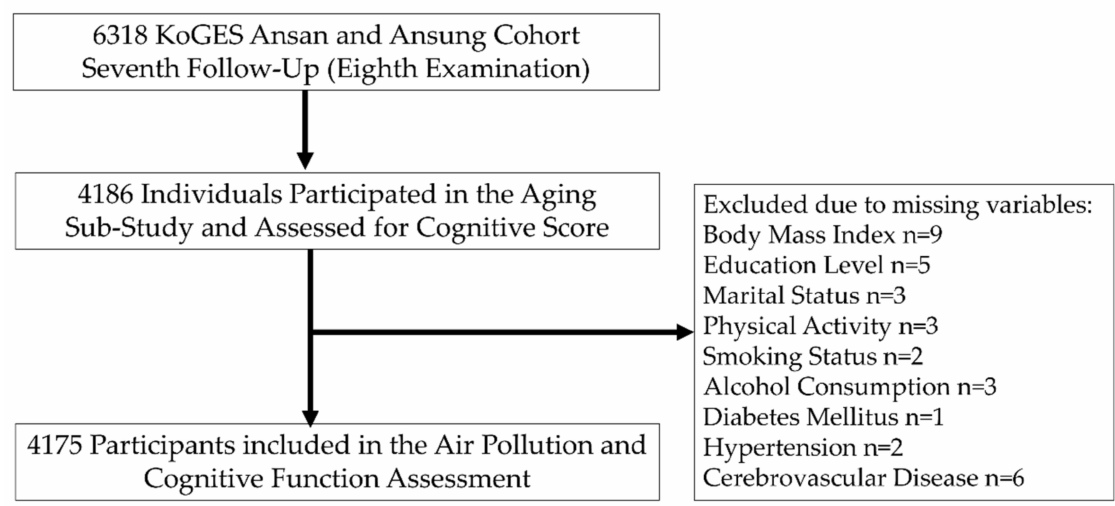
Figure 1. Flowchart of study